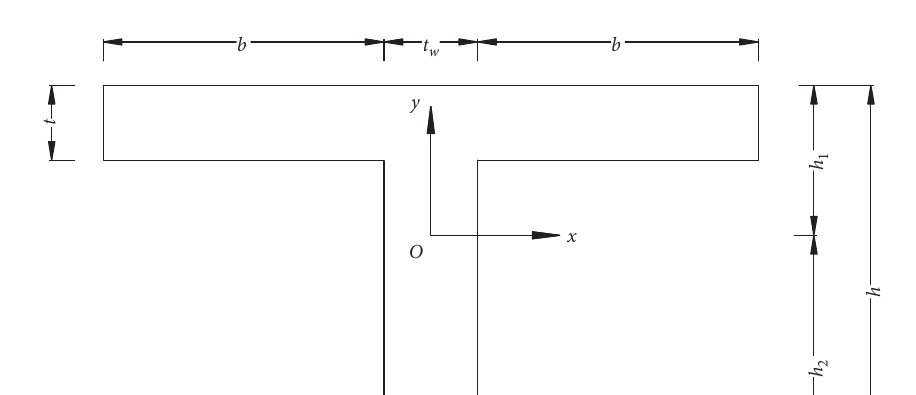
Figure 1: Coordinate and load system.